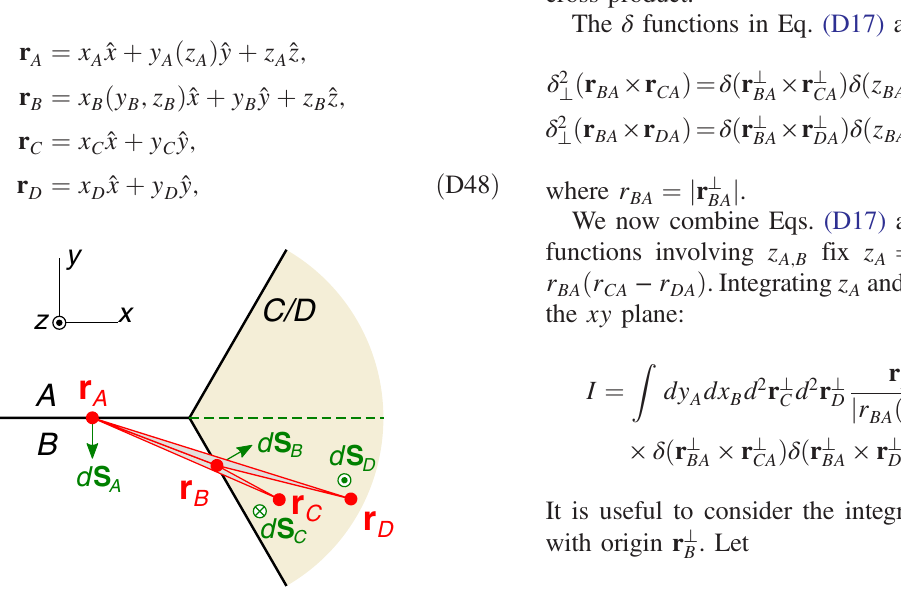
FIG. 17. Coordinate system for calculating the contribution to I when r form a straight line on the CD double contact A;B;C;D plane, where points are ordered as ABCD . The origin is set at the point where the three rays (separating different regions) meet, and the CD plane is at z ¼ 0